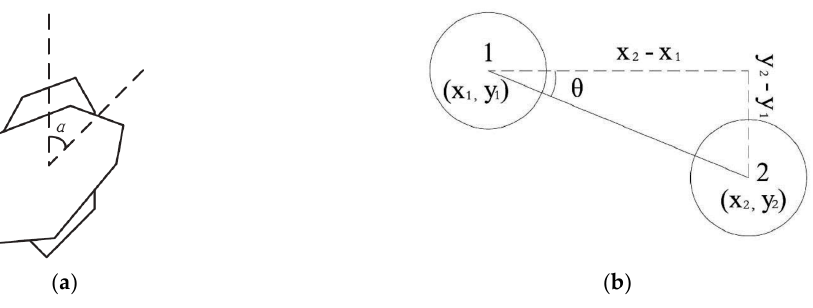
Figure 18. Movement of the coarse aggregate. ( a ) Rotation; ( b ) Transition.